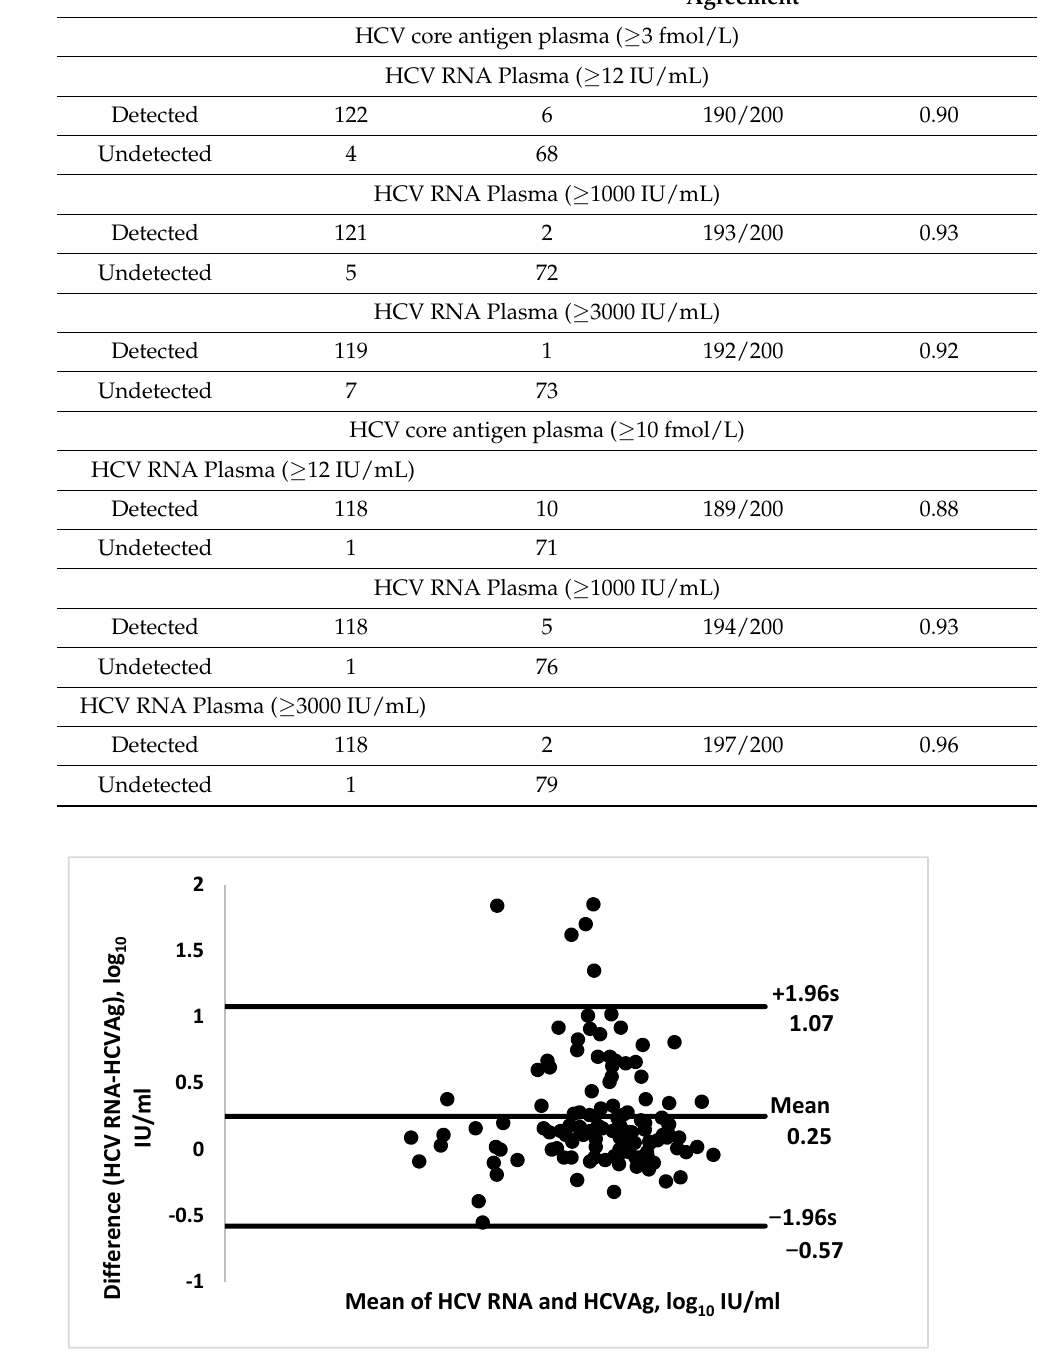
Table 4. Diagnostic analysis of HCV core antigen plasma compared with HCV RNA ( n = 200).